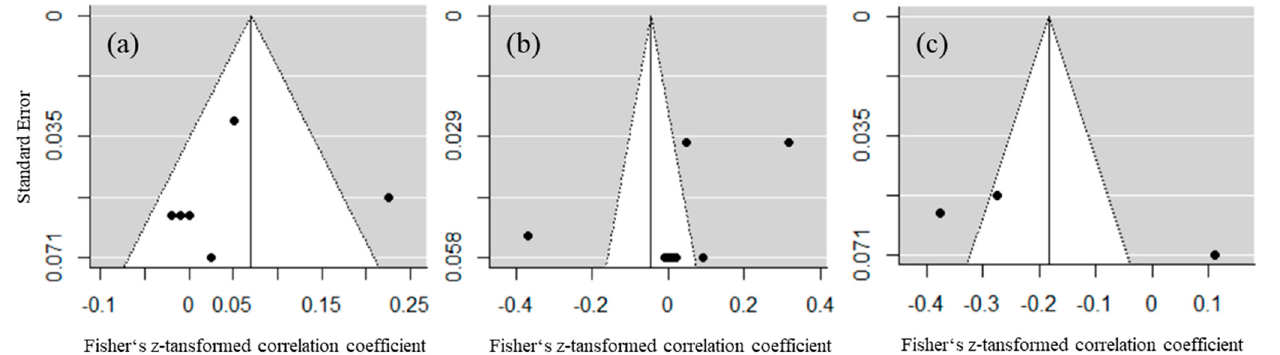
Figure 2. Funnel plots for publication bias between studies for the bidirectional relationships. ( a ) Physical activity and academic performance; ( b ) physical activity and stress; ( c ) stress and academic performance.